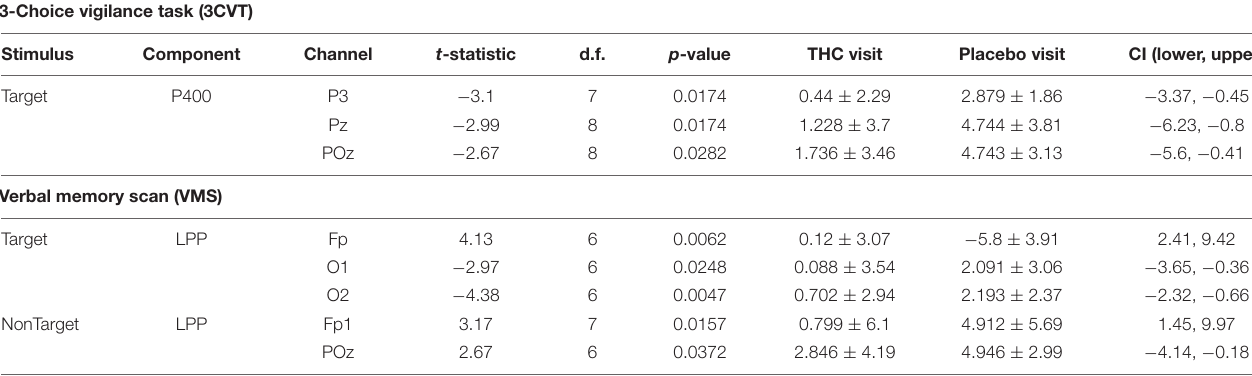
FIGURE 4 | Three-choice vigilance task, Target stimulus at P400 component. (A) Amplitude of P400 peak following Target stimulus elicited an attenuated response during THC visit across parietal and occipital channels. Topographic maps represent average amplitudes between 275 and 475 ms post-stimulus. Difference between visits was significant at P3, Pz, and POz. (B) Average ERP traces for adjacent posterior channels reveal flattened P400 peaks associated with THC visit. Asterisk at P3 indicates significance at α = 0.05. Gray boxes depict P400 time range. THC visit, red line; Placebo visit, blue line. TABLE 3 | Event-related potentials, significant comparisons between THC and placebo